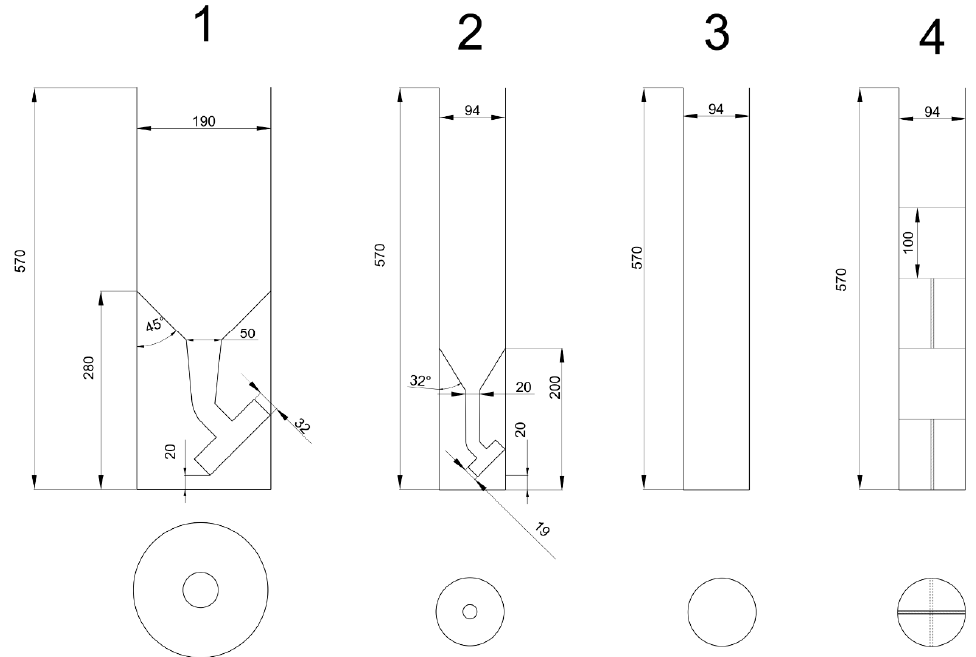
Figure 2. Geometric and structural parameters of sediment traps systems (described dimensions are expressed in millimeters (mm)). Trap No. 1 was an innovative design solution consisting of dual-chamber cylindrical vessel with a sedimentation funnel, at the end of which a deflector was placed at an angle of 45 o . The ratio of height to diameter of the trap (h/d) was 3. Trap No. 2 was of an analogous innovative design to trap 1, but with a ratio of height to diameter of the trap (h/d) equal to 6.06. Trap No. 3 was a simple construction consisting of a single-chamber cylindrical vessel, with a ratio of height to diameter of the trap (h/d) equal to 6.06. The design of this trap represented the currently used traps (the reference trap). Trap No. 4 was an innovative design solution consisting of a cylindrical vessel with a trap height to diameter ratio of 6.06. However, inside the trap there were additional vertical barriers made of plexiglass plates, each 100 mm in height. A total of four rows of plates were used, placed in such a way that their projections formed a cross-shaped system.